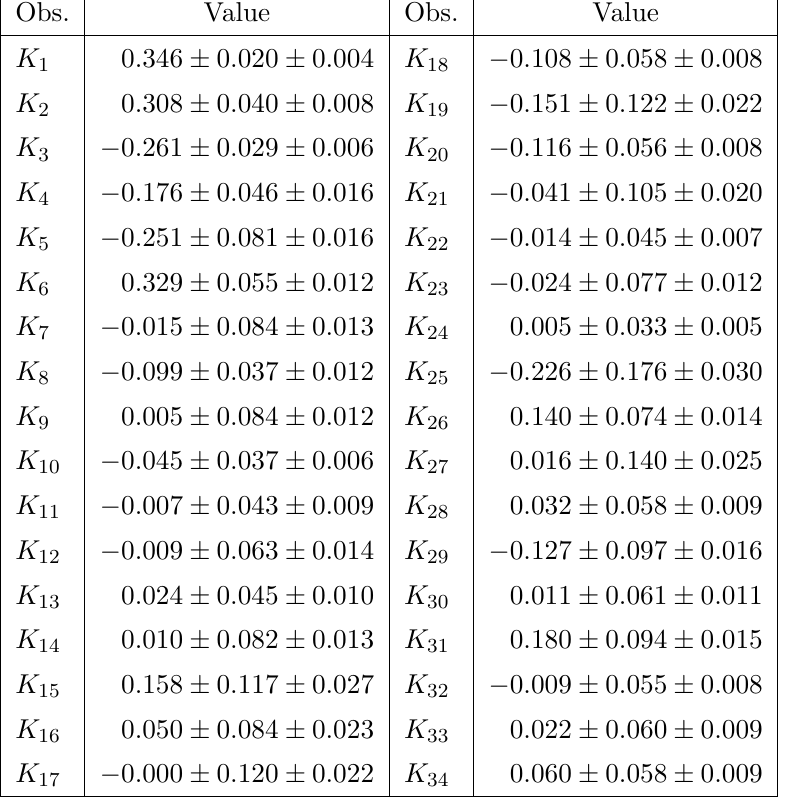
Table 1 . Angular observables combining the results of the moments obtained from Run 1 and Run 2 data, as well as candidates reconstructed in the long- and downstream-track p(cid:25) (cid:0) categories. The (cid:12)rst and second uncertainties are statistical and systematic,